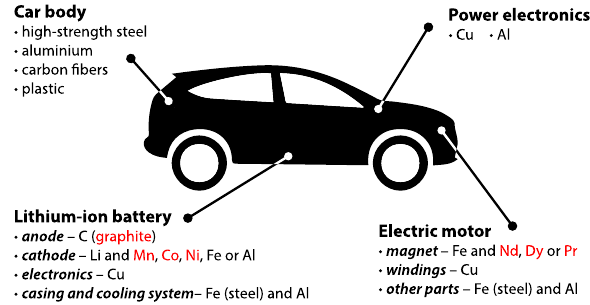
Figure 7. Most relevant materials used in different parts of battery electric vehicles. Those defined as critical are highlighted in